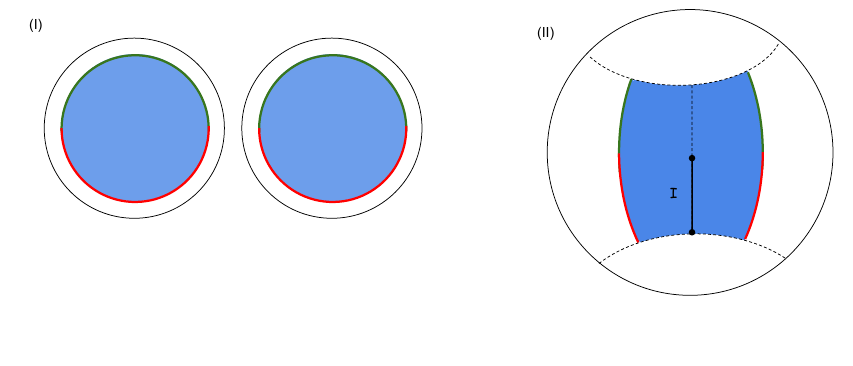
Figure 7. The two replica geometries: (I) is the disconnected saddle, (II) is the connected saddle which is the external traversable wormhole geometry by gluing alond the dashed line. The two red (green) lines are glued